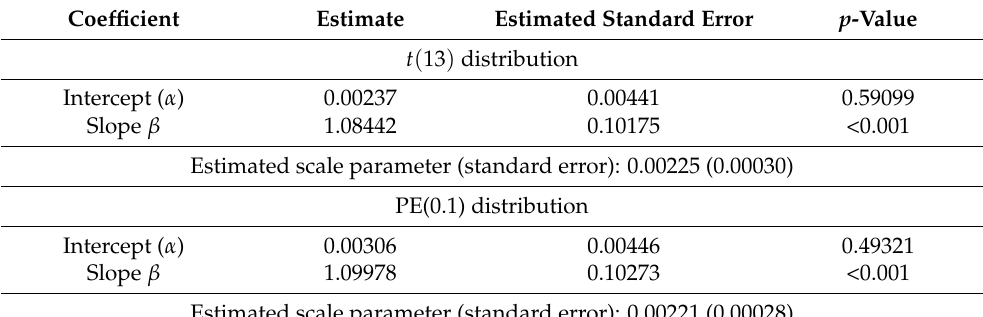
Table 7. Linear regression for the CAPM under the indicated distribution with monthly returns. Coefficient Estimate Estimated Standard Error p -Value t ( 13 )